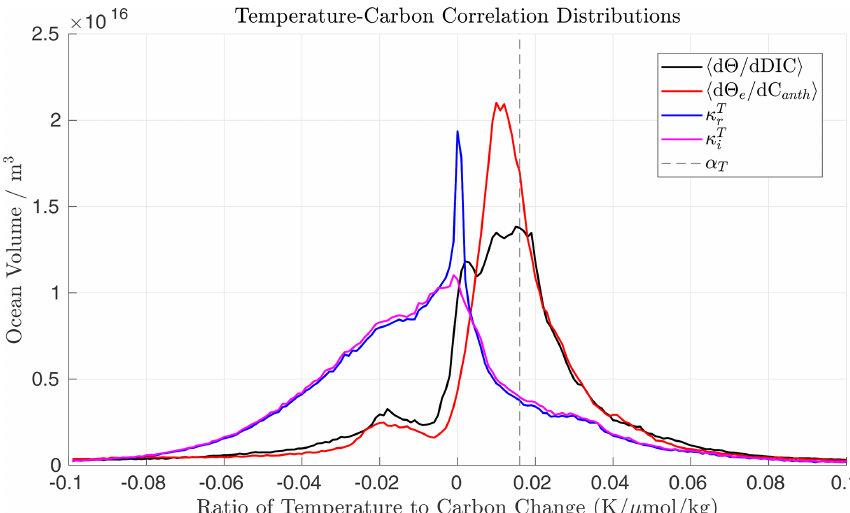
Figure 1. Histograms of the distribution of correlations relating different components of the temperature and carbon fields over the full simulation (1860–2099). The global mean value α T is shown by the dashed line. We include both the final redistribution coefficient, κ T r (blue), and its intermediate estimate, κ T (magenta), as well as the ratio of total temperature change to DIC change ( (cid:104) d θ/ dDIC (cid:105) , black) and i local excess temperature to anthropogenic carbon change ( (cid:104) d θ e / dC anth (cid:105) , red).